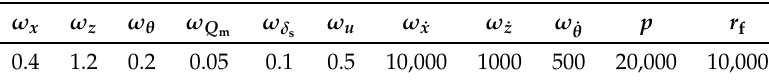
Table 3. Weights used by the RL reward function.